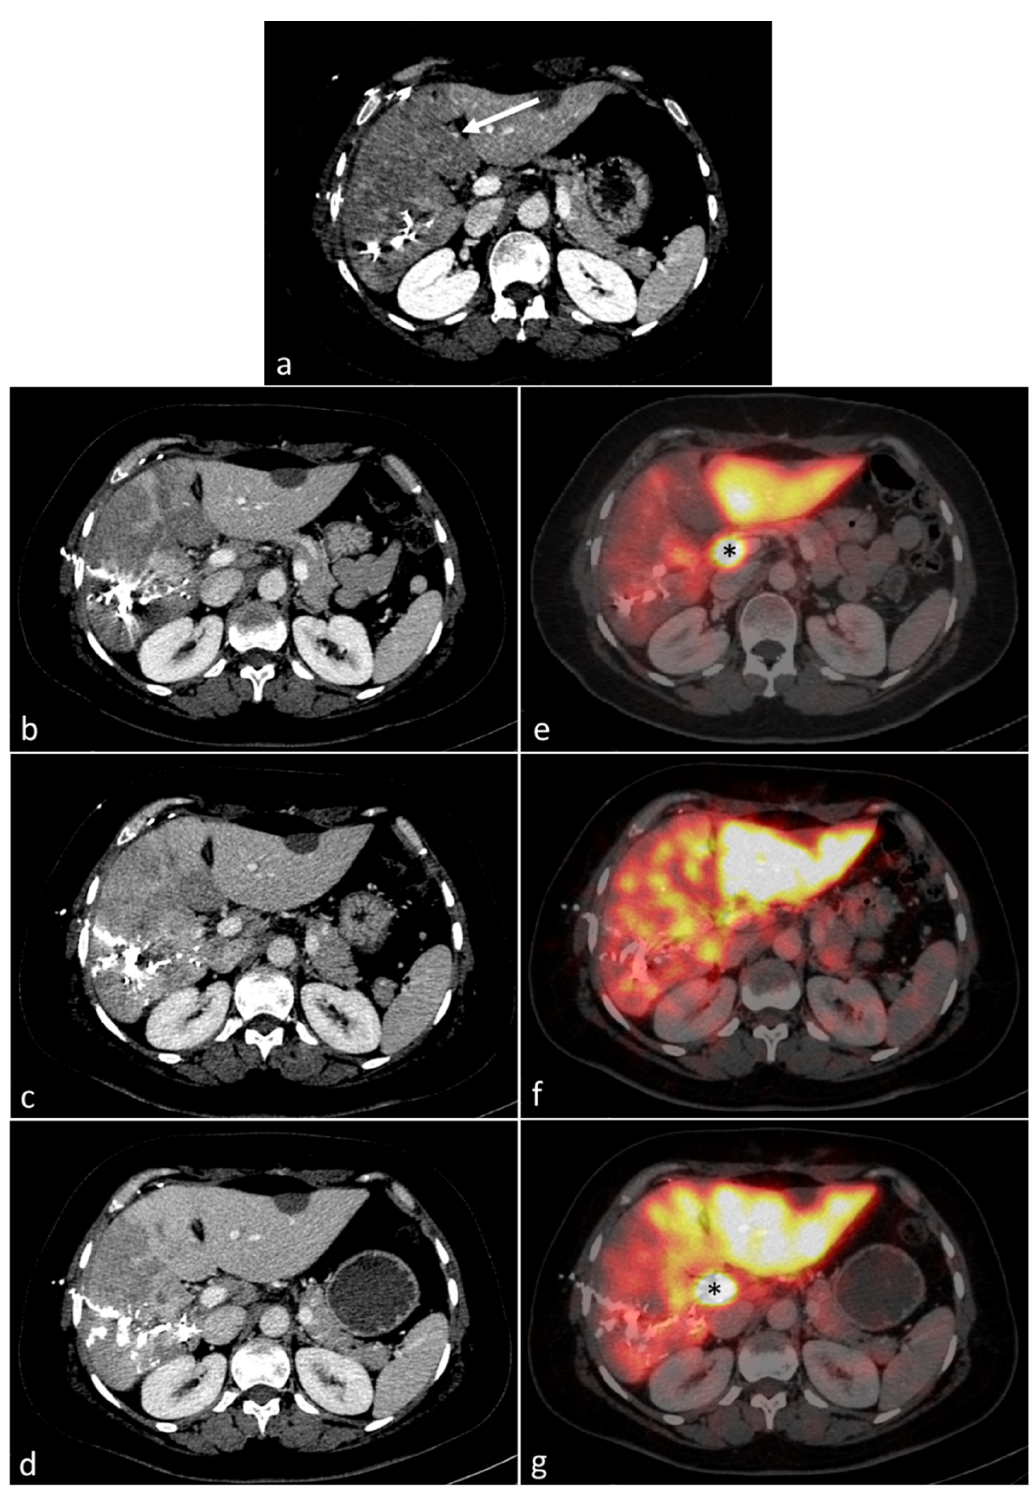
Figure 4. Axial portal venous phase CT at day 1 after eLVD ( a ) showing hypoattenuation in S4 (arrow), which progressively recovers at days 7 ( b ), 14 ( c ) and 21 ( d ). Corresponding 99mTc-mebrofenin SPECT-CT images of the same patient showing progressive increase in S4 function at days 7 ( e ), 14 ( f ) and 21 ( g ). Please note artifactual activity due to the radiotracer accumulation in the main bile duct (black asterisk).